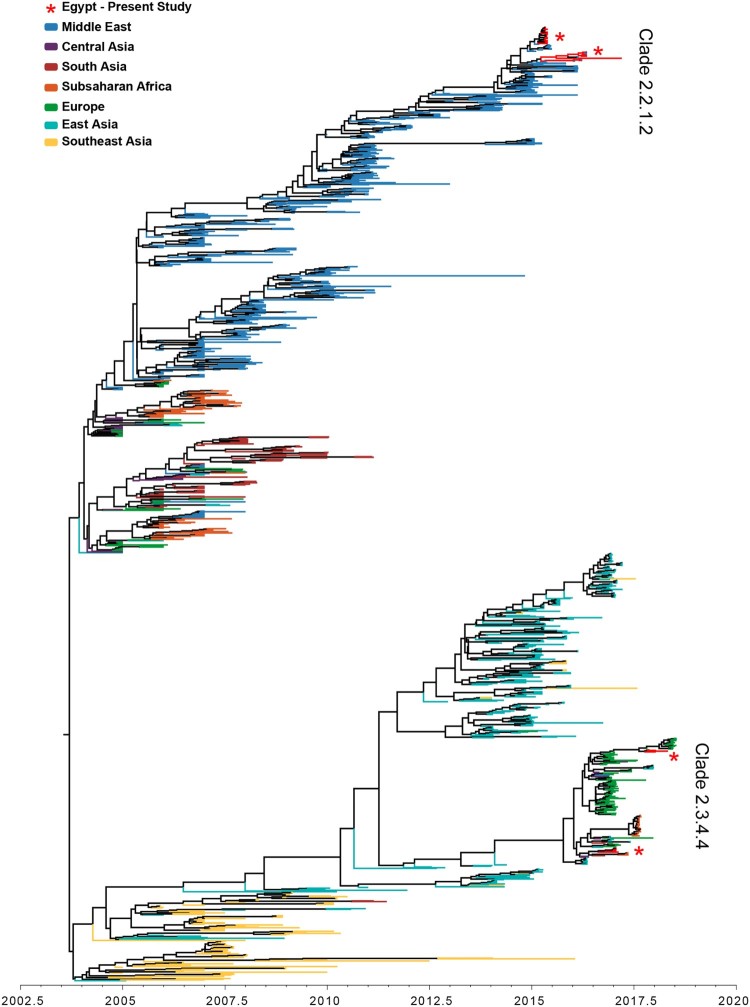
Phylogenetic tree of the nucleotide sequences of H5 genes of characterized from Egypt, Europe, Central Asia, the Middle East, Sub-Saharan Africa, and South Asia collected between January 1, 2005 and September 2018.